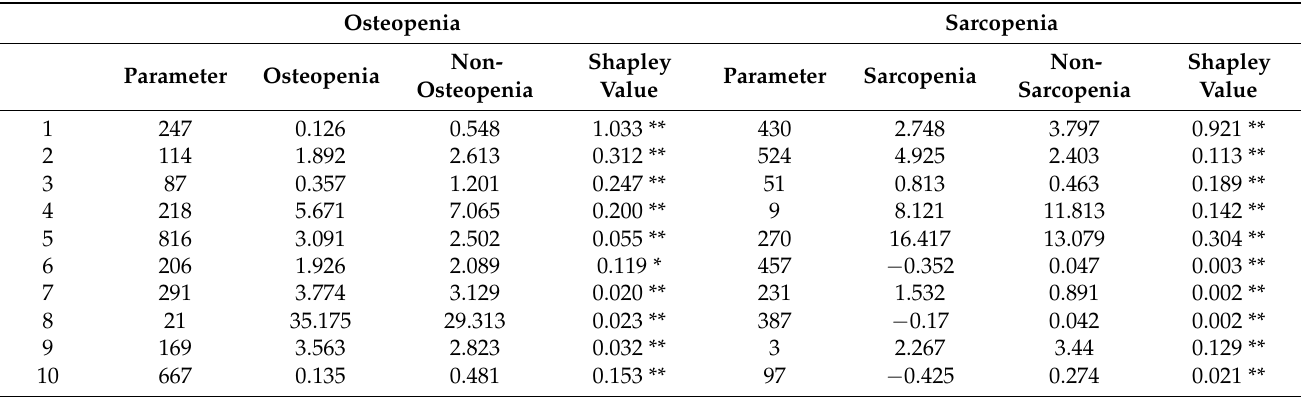
Table 13. Descriptive statistical parameters of osteopenia and sarcopenia. * indicates that the p -value is less than 0.025, and ** indicates that the p -value is less than 0.001. Osteopenia Sarcopenia